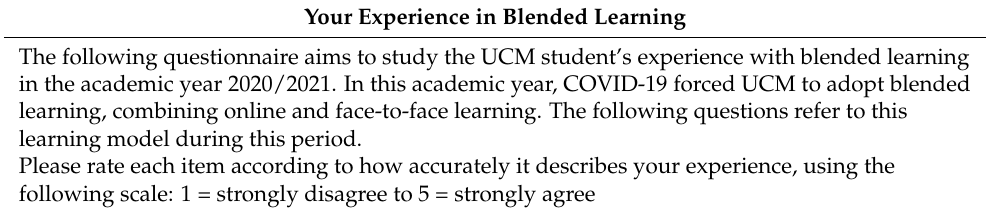
Table A2. Survey. (This survey has been translated from its original version used with the